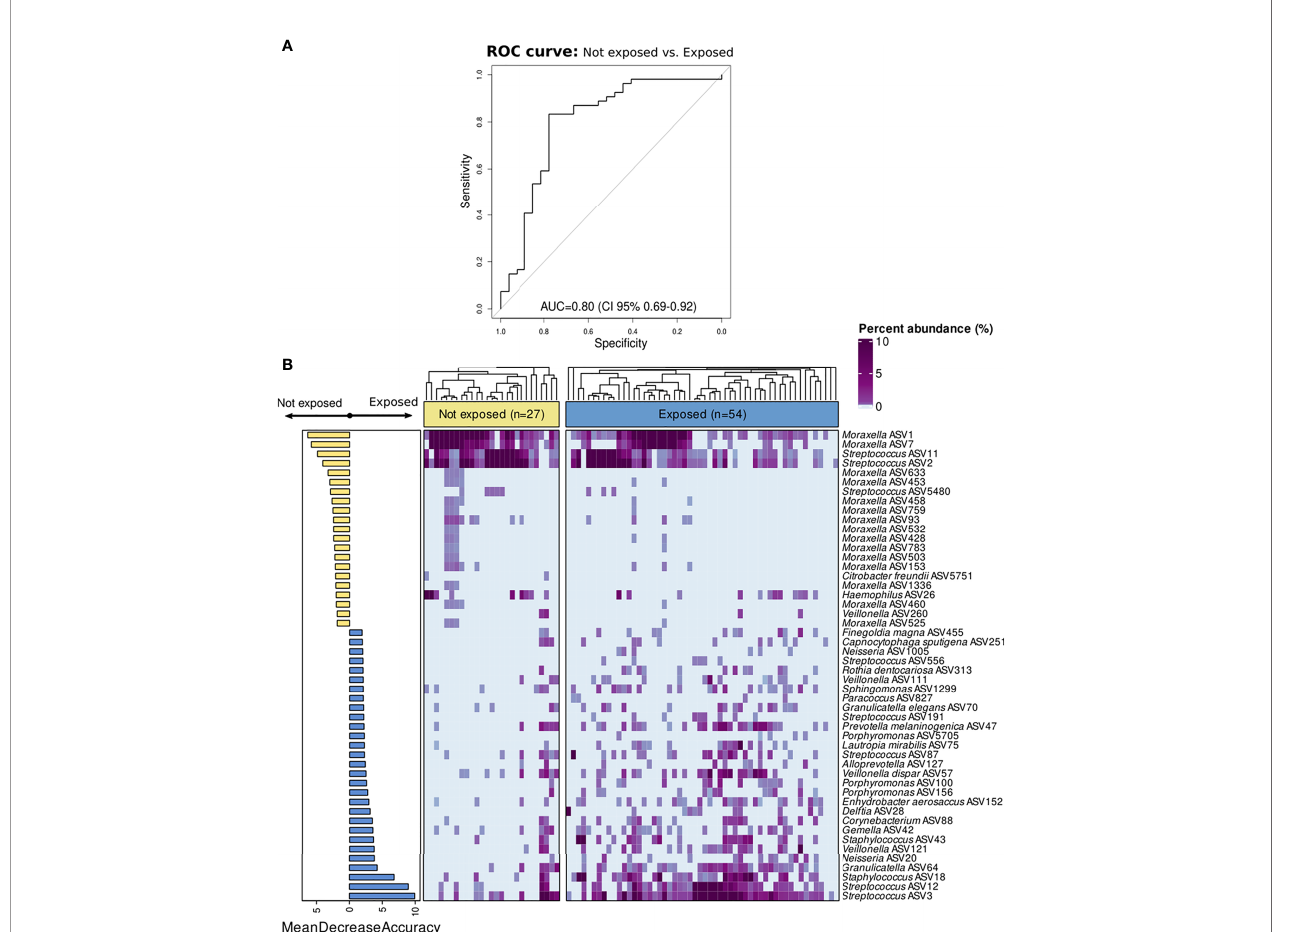
FIGURE 3 | Classi fi cation of children with IPD according to antibiotic-exposure using a Random Forest model based on nasopharyngeal microbiota composition. All ASVs as well as confounding factors (age, gender, seasonality, vaccination, ICU admission, and length of hospital stay) were included in the model. (A) ROC curve showing the performance of the RF model at the ASV level. (B) Bar plot showing top 50 most important features to class separation according to the Mean Decrease Accuracy score (confounding factors were not found among the top important features). Color-coding shows directionality of the association for each of the 50 top features to either the not exposed (yellow) or antibiotic-exposed (blue) group based on a post hoc analyses with Cliff ’ s delta estimation of the effect size. In addition, a heatmap displaying relative abundance (%) of these top 50 features across samples is shown on the right. Each column represents a sample, while each row represents a different feature. In the x-axis, samples are split by group and ordered according to hierarchical clustering using a Bray – Curtis dissimilarity